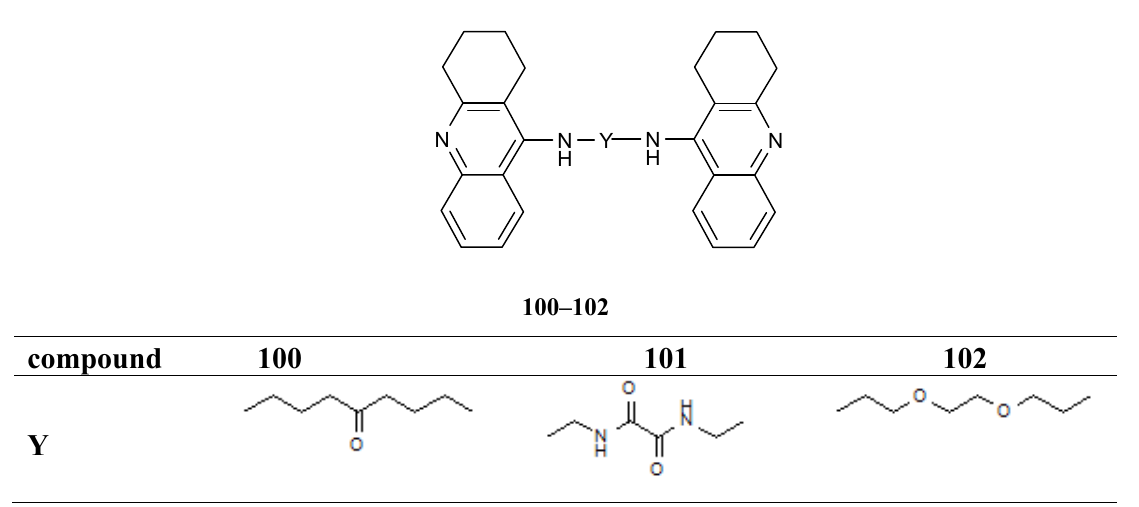
Figure 19. Multifunctional bis -tacrines 100–102